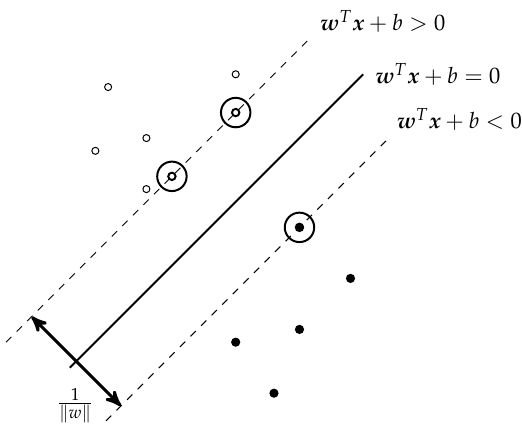
Figure 5. Assuming a two-dimensional case and linear separability of the points belonging to different classes, the margin between the support vector machines’ splitting hyperplane (solid line) and both subspaces’ closest points defines two boundary hyperplanes (dashed lines), should be maximized. The three points, two “white” and one “black”, on the boundary hyperplanes determine the slope of the splitting and boundary hyperplanes and, therefore, are called support vectors